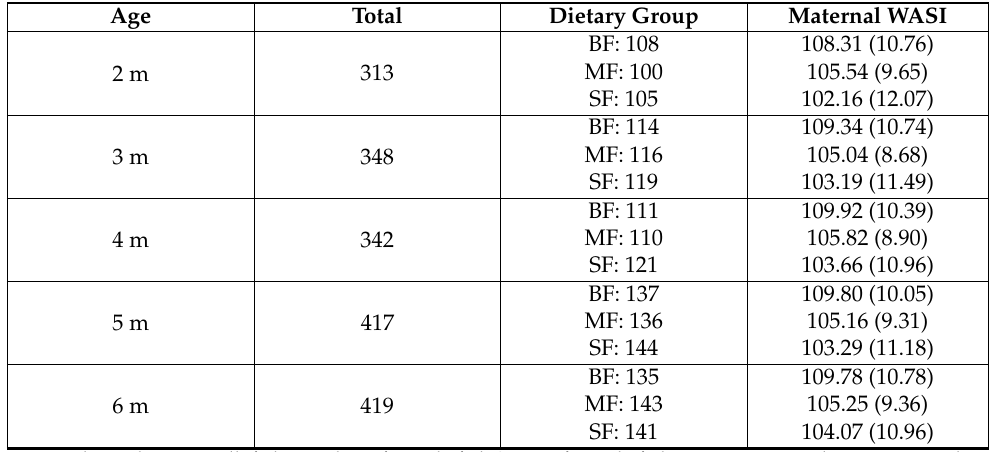
Table 1. Characteristics of Dietary Group by